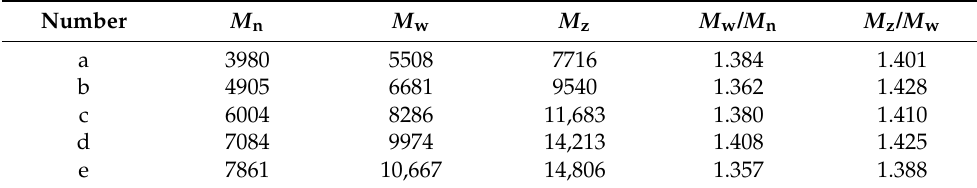
Figure 5. ( A ) Epoxy resin gel permeation chromatogram; ( B ) effect of different catalyst amounts on epoxy equivalents; ( C ) relationship between reaction temperature and reaction time. Table 2. Molecular weight and distribution of epoxy resin.